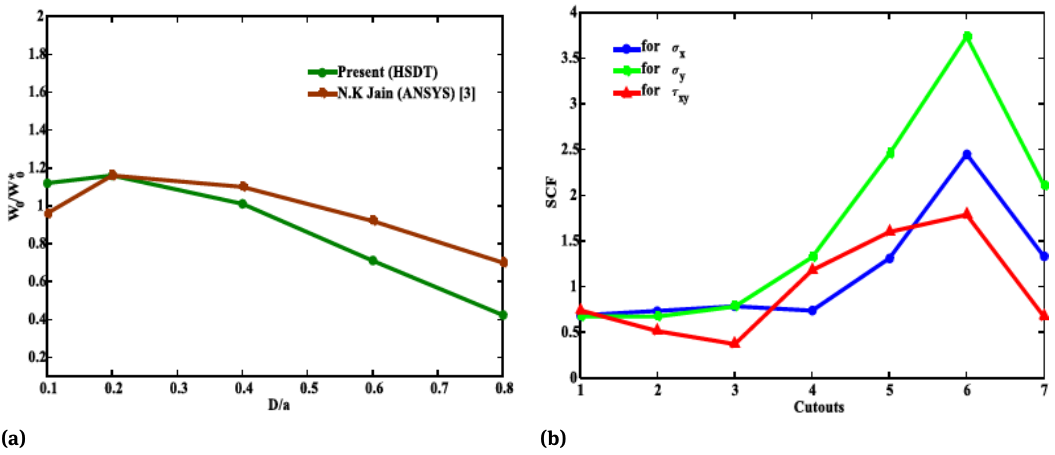
for orthotropic plate with CSCS boundary condition. (b) Effect of cutout on SCF for LCSP in simply 0